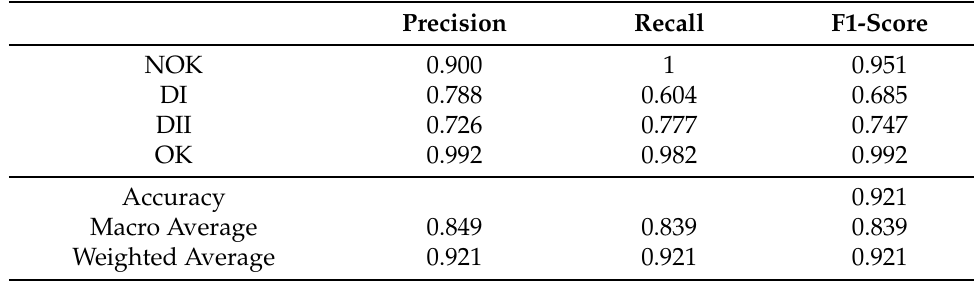
Table 8. Negri Bossi classification